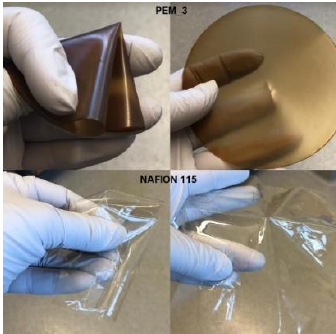
Figure 2. Comparing the final product with Nafion 115 using the non-mechanical folding test.